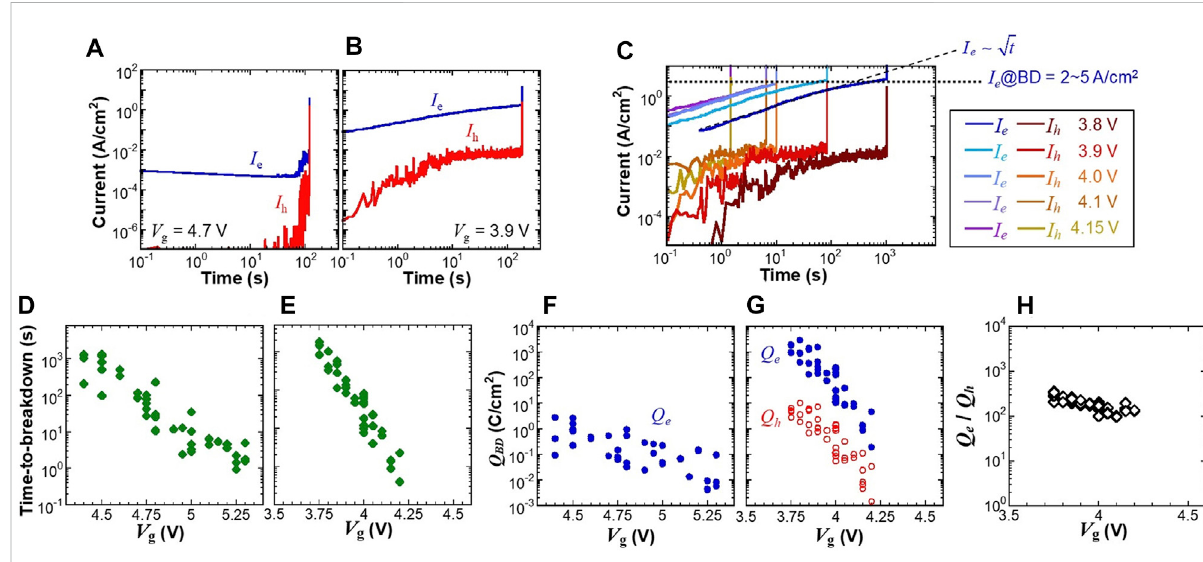
FIGURE 7 TDDB results with carrier separation for (A) HfO 2 non-ferro-FET at V g = 4.7 V and (B) HZO FeFET at V g = 3.9 V with L / W = 100/100 μ m. A SILC- like behavior, with current increasing with stress time, can be observed in FeFETs. (C) TDDB of FeFET at different stress voltage V g . Electron current (cid:1) √ increaseswithtimebyapproximately I e ∝ t .Theelectronandholecurrentlevelsatbreakdownhaveweakdependencyon V g .Time-to-breakdown of (D) non-ferro-FET and (E) FeFET under constant voltage stress. The FeFET has astronger dependence on V g . Charge-to-breakdown Q BD for (F) non-ferro-FET and (G) FeFET under constant voltage stress. Q BD in the FeFET strongly depends on stressing voltage, whereas Q BD in the non- ferro-FET is almost constant. (H) Q e / Q h ratio at breakdown condition for